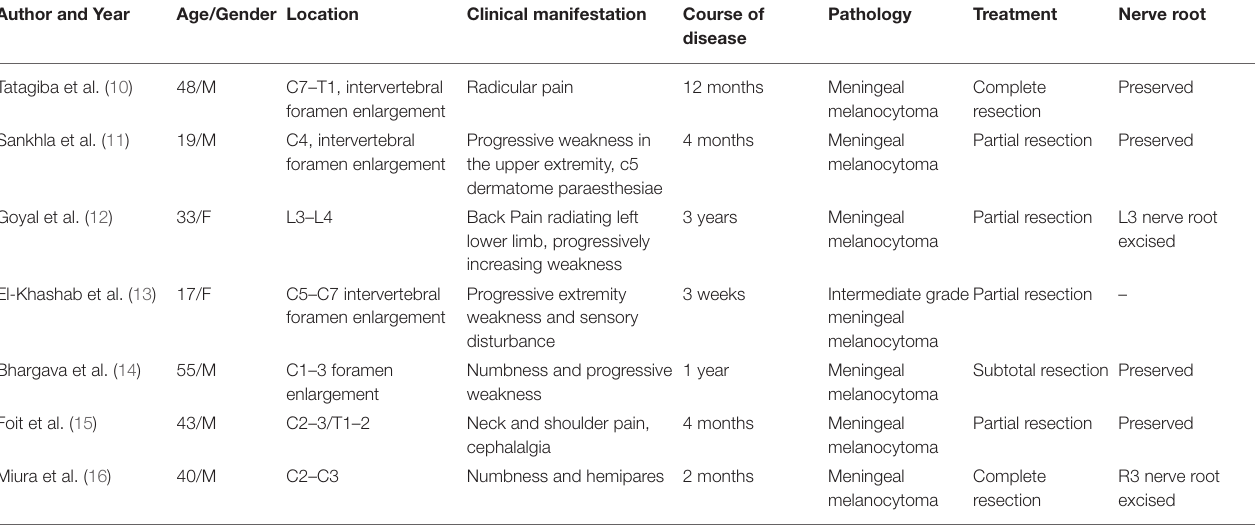
TABLE 1 | Previously published reports of dumbbell-shaped spinal meningeal